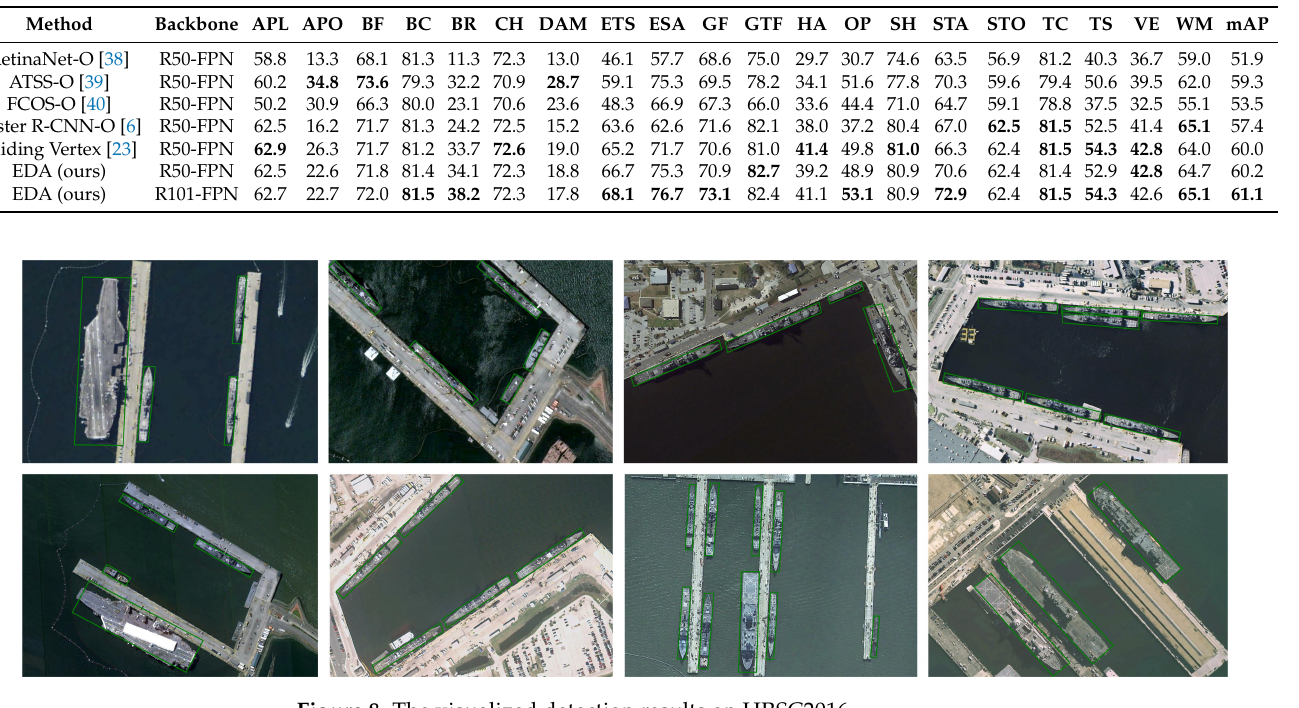
Figure 8. The visualized detection results on HRSC2016. Table 5. Quantitative comparisons on